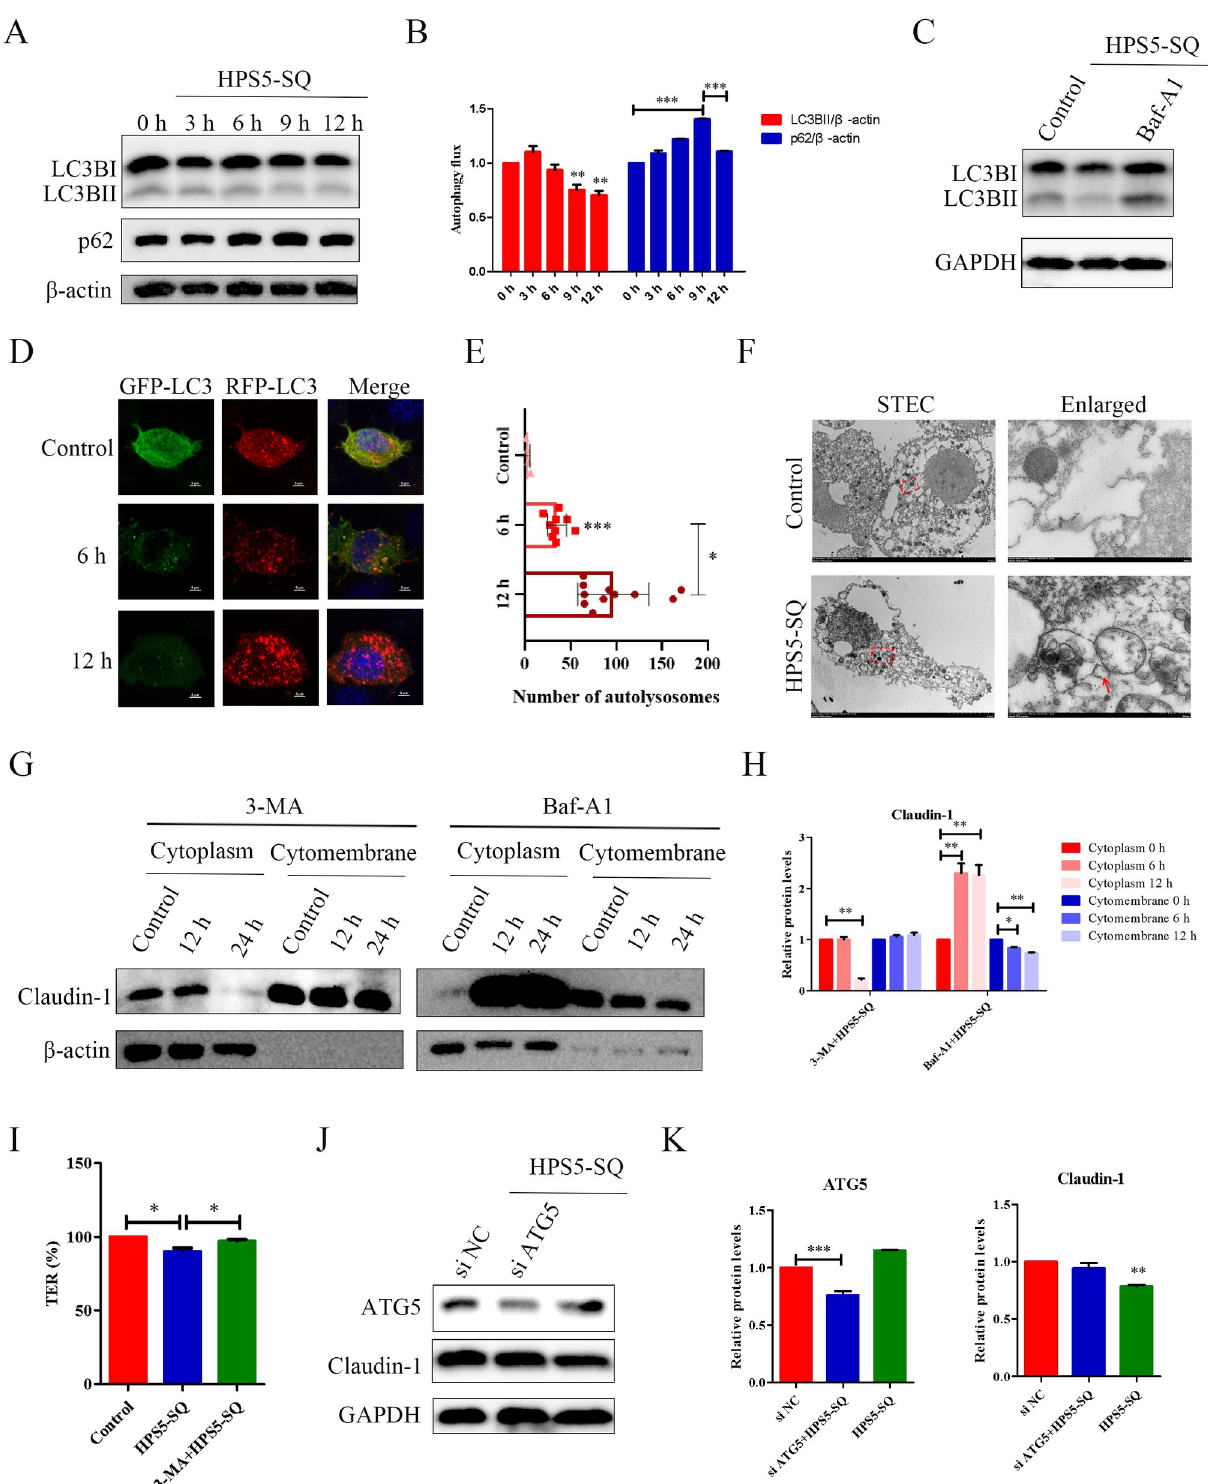
Fig 3. Autophagy cuts off the replenishment of Claudin-1 on the cell membrane. (A) STEC were either controlled or infected by HPS5-SQ at an MOI of 100; whole-cell extracts were prepared from control-infected and HPS5-SQ-infected cells at 3, 6, 9, and 12 hpi. LC3BII and p62 levels were determined by Western blot. (B) Quantification of LC3BII and p62. Data shown are means ± SEM; �� P < 0.01; ��� P < 0.001. (one-way ANOVA). (C) STEC were treated with or without Baf-A1 for the final 4 h and then infected with or without HPS5-SQ (MOI of 100); whole-cell extracts were prepared from